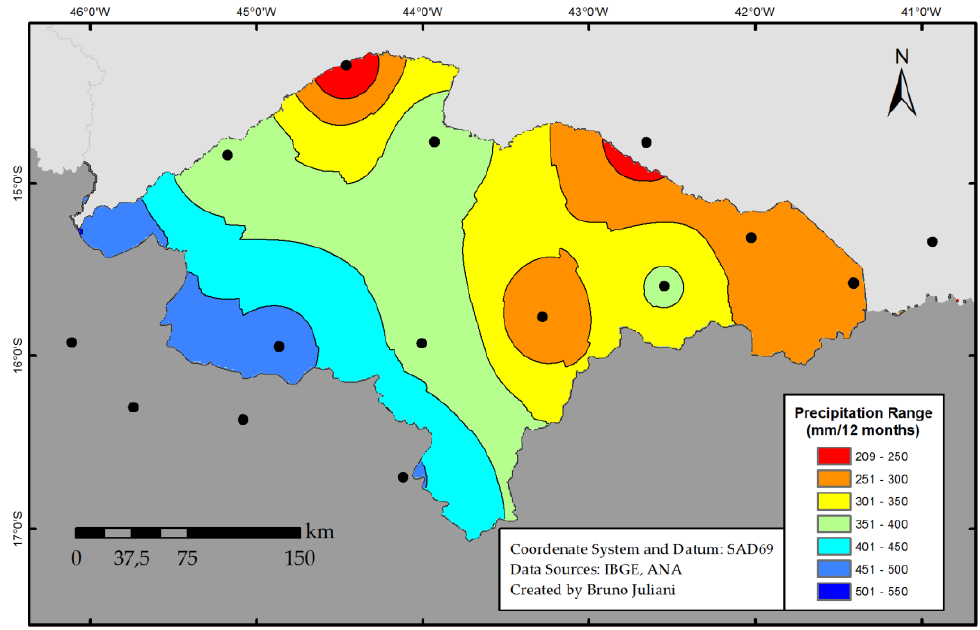
Figure 8. Isohyetal map of cumulative 12-month precipitation for analysis of 1-month drought and average recurrence interval of 100 years.